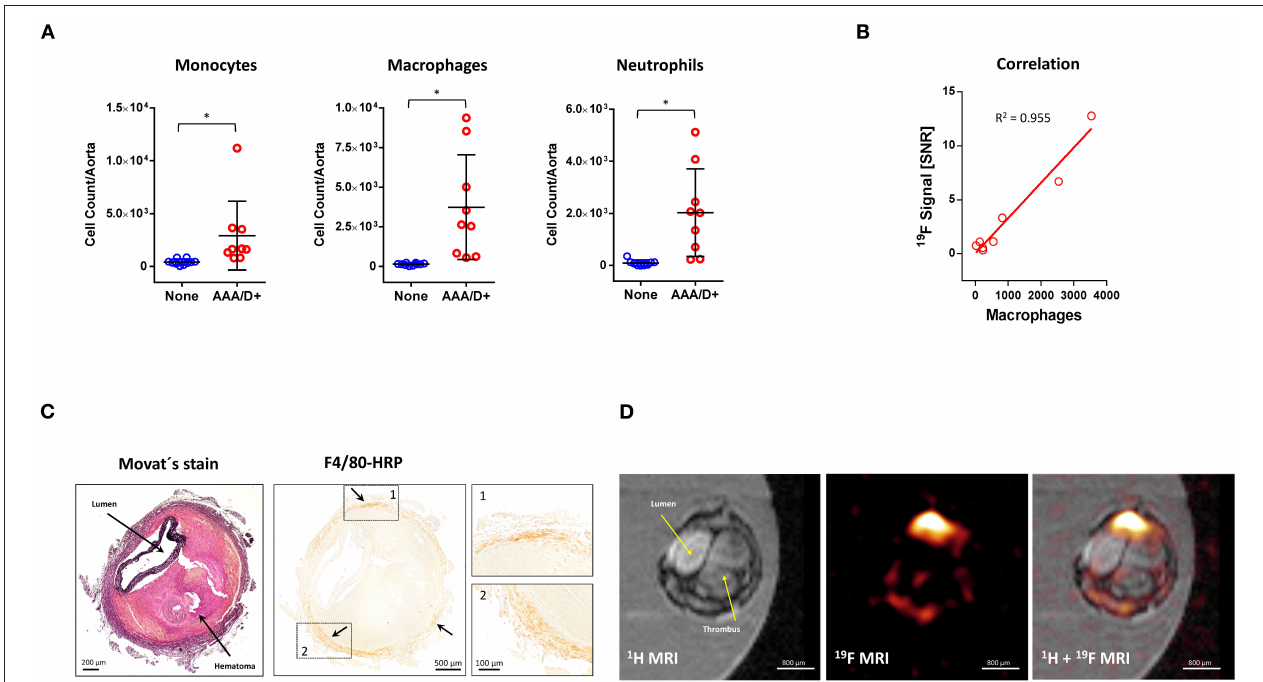
FIGURE 4 | Flow cytometric and histological validation of in vivo MRI data. (A) Flow cytometry of myeloid immune cells isolated on day 10 of angII treatment from aortae without AAA/AAD or vascular inflammation (None) and aortae with AAA/AAD (AAA/D + ). (B) Correlation of the vascular 19 F signal with the total number of aortic macrophages determined by flow cytometry. (C) Histological sections were stained with Movat’s (left) or incubated with antibodies against F4/80 followed by horseradish peroxidase (HRP) reaction (right). Arrows show the localization of the brown HRP-positive signals. The dashed lines indicate the magnified areas on the right (D) High resolution ex vivo 1 H/ 19 F MRI measurements of an excised and paraformaldehyde fixed aorta with AAD that was embedded in agarose. Data are statistically significant with * p ≤